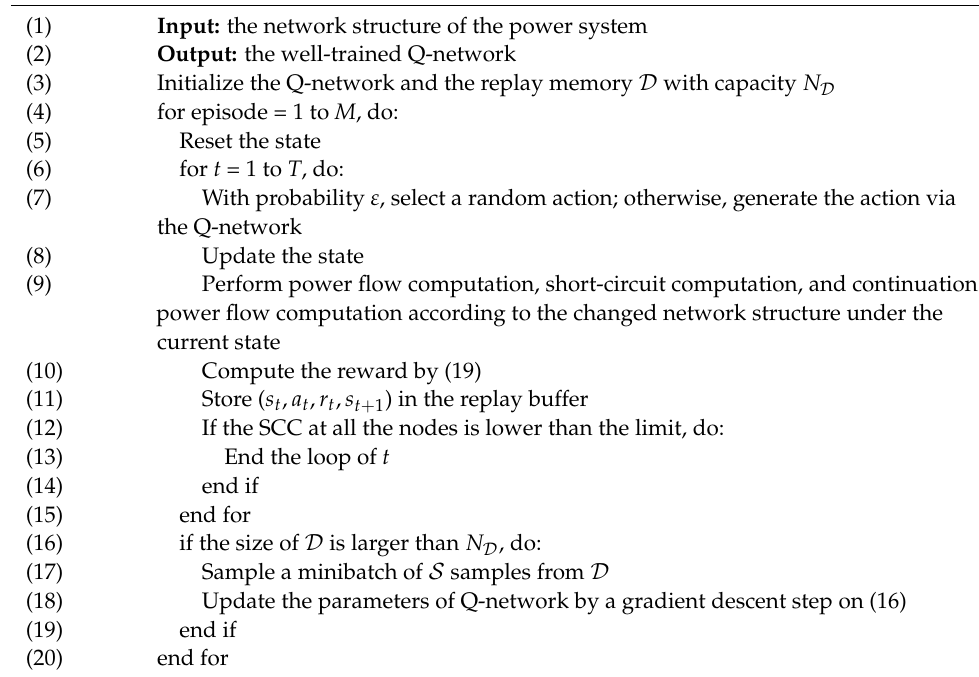
Algorithm 1 Training Procedure of OTS